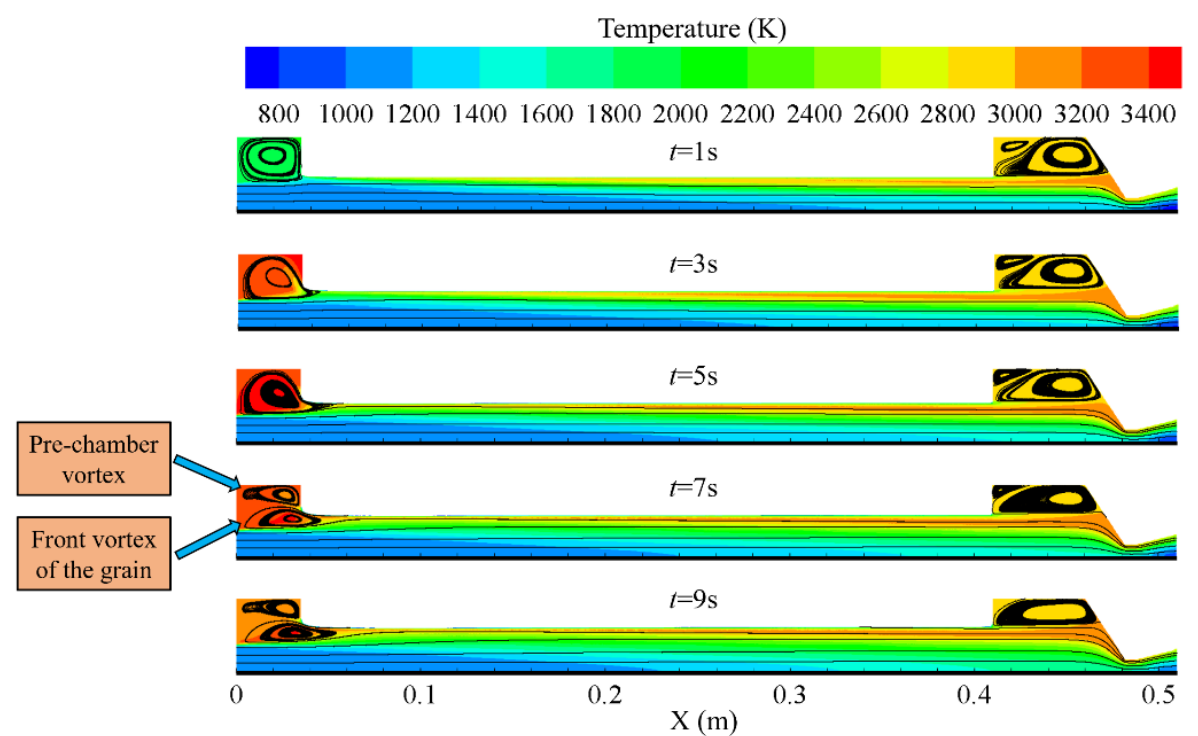
Figure 10. Temperature contour and streamline with time.